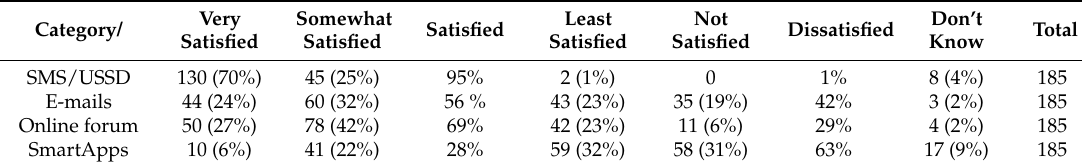
Table 3. User preference for different e-participation channels.